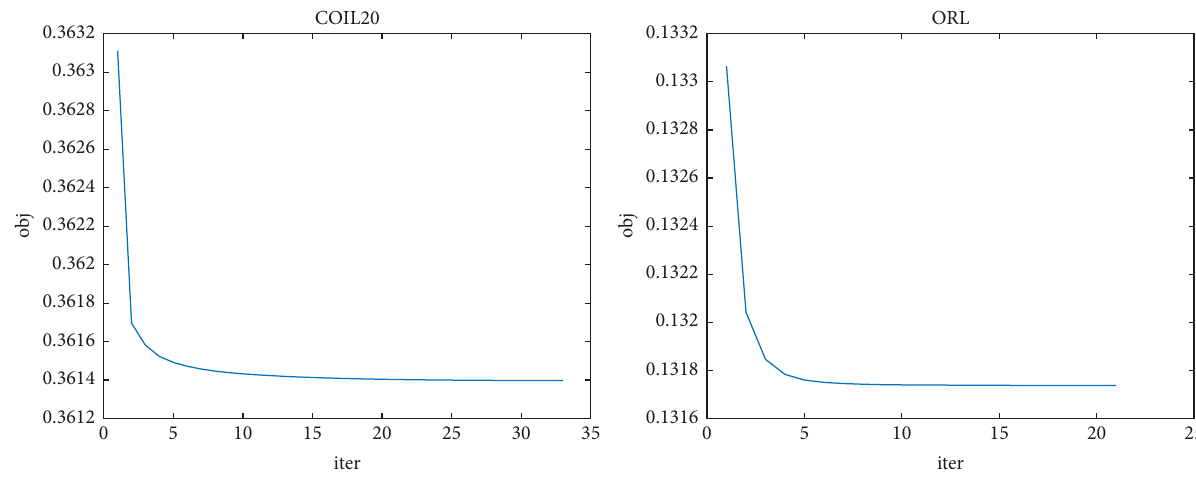
Figure 7: The convergence curve of the proposed method on COIL20 and ORL. Table 7: Computation time (in seconds) of each method on three benchmark datasets. The experiments are conducted on an eight- core windows with each core’s CPU at 4.2GHz; the total memory is